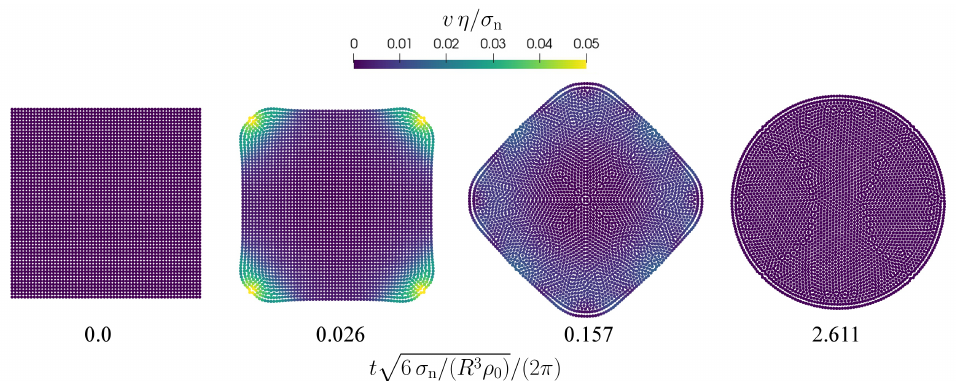
Figure 4. Formation of a droplet from a square under the influence of surface tension. The normalized velocity magnitude is color-coded. The time is normalized using a characteristic oscillation frequency according to Equation